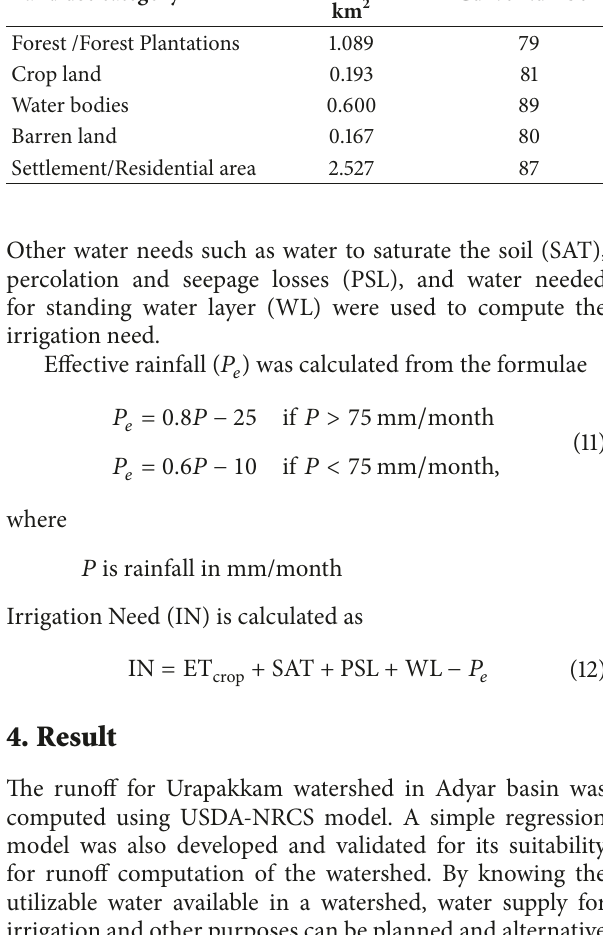
Table 2: Land use details and the corresponding curve numbers. Land use catego r y